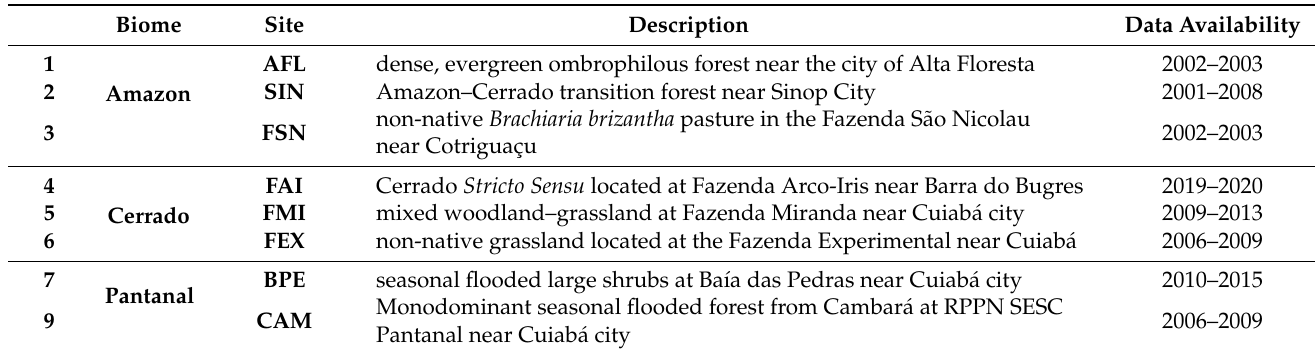
Table 1. A summary of the field measurements periods over the study sites AFL, SIN, FSN, FAI, FMI, FEX, CAM, and